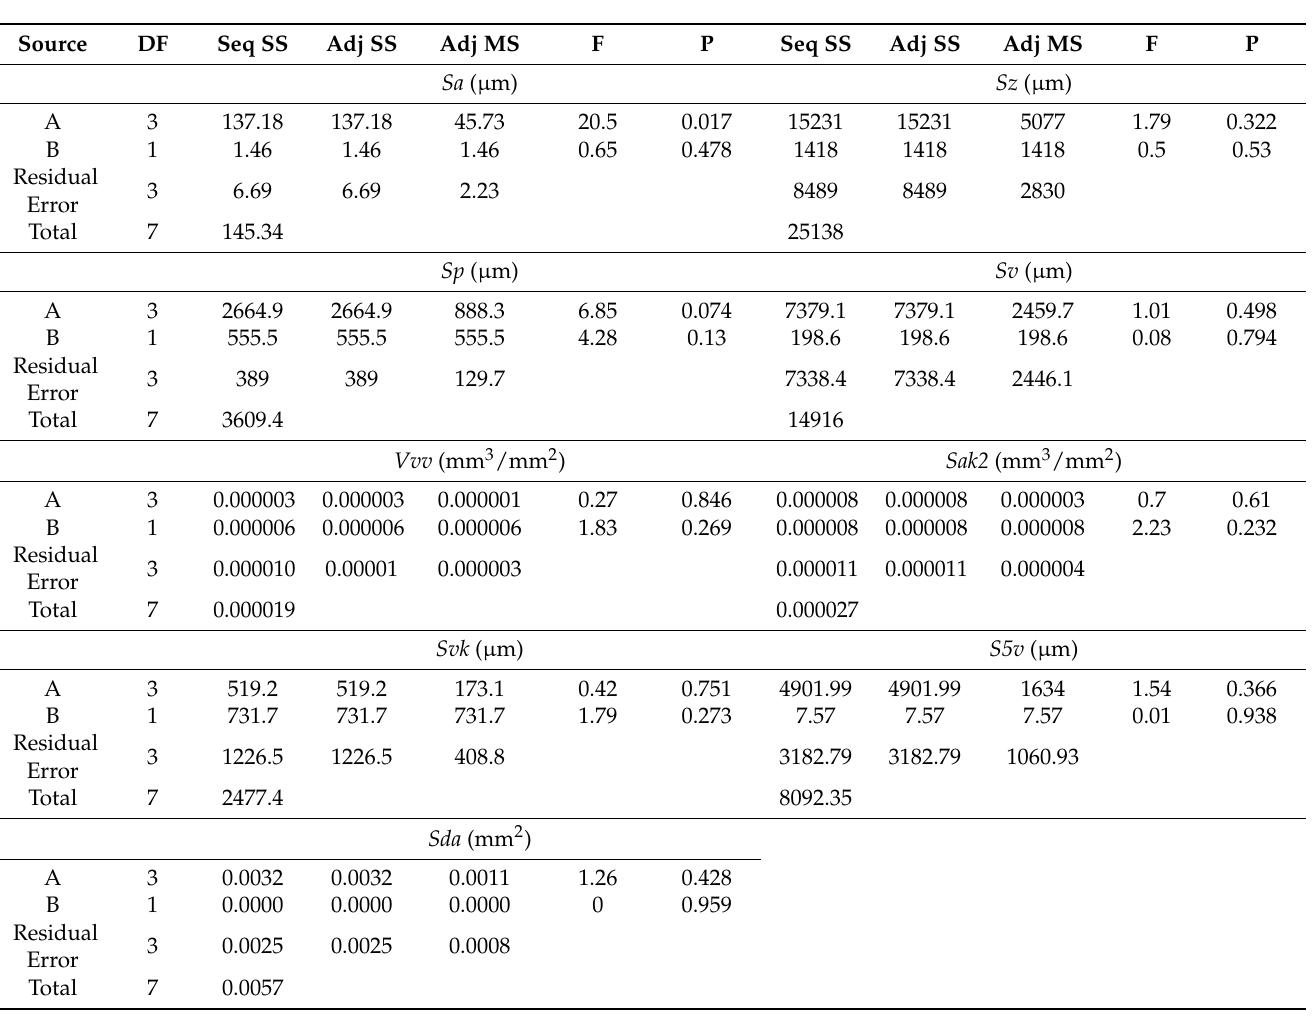
Table 5. Analysis of Variance for